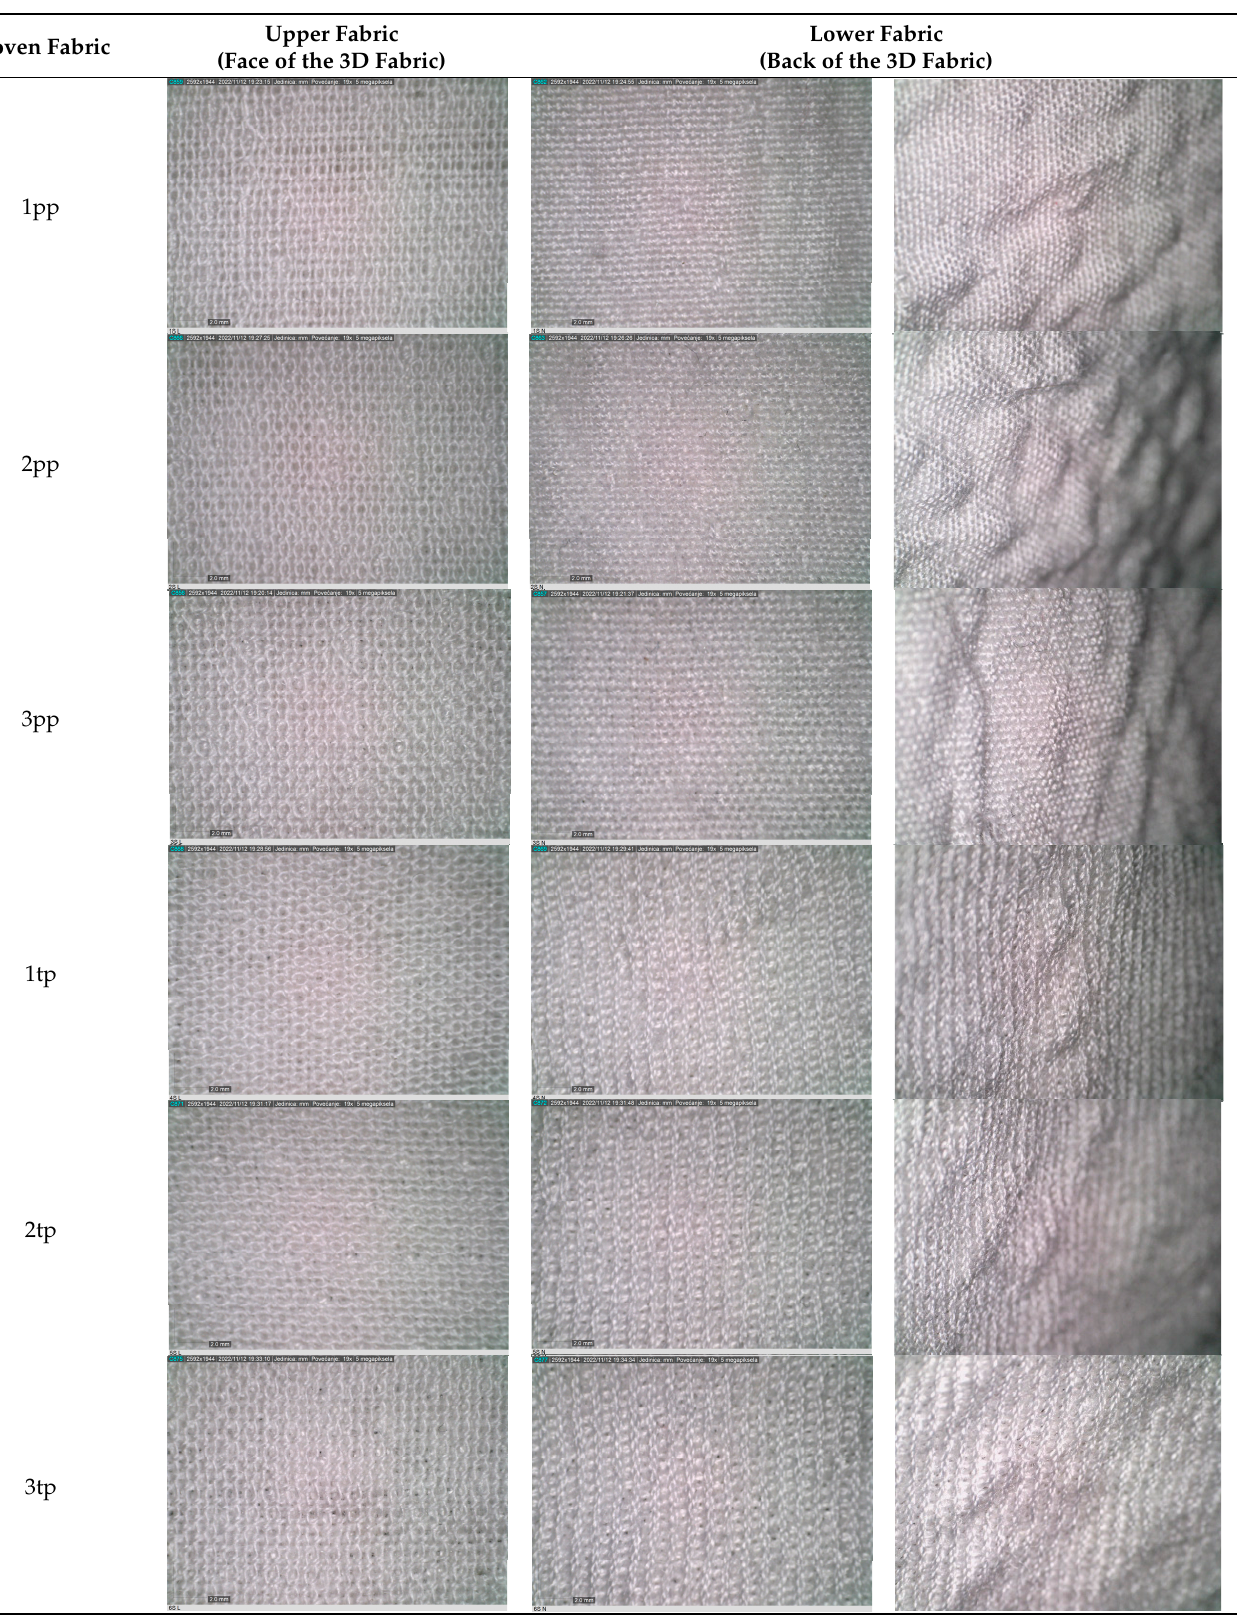
Table 2. Microscopic image of the surface of 3D-woven fabrics, by sample.